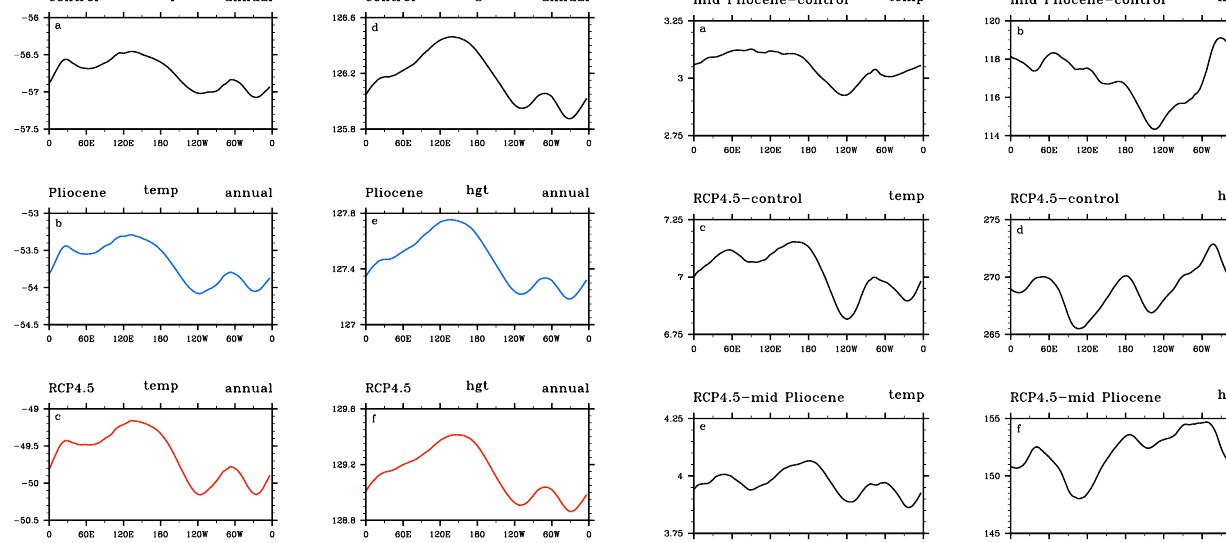
Fig. 8 (a) vertically averaged upper level (from 400hPa to 100hPa) temperature 2 Fig. 8. (a) Vertically averaged upper level (from 400hPa to 100hPa) anomaly (units: ºC) between mid-Pliocene and control run. (b) Potential height 3 temperature anomaly (units: ◦ C) between mid-Pliocene and the control run. (b) Potential height anomaly (units: m) between mid- anomaly (units: m) between mid-Pliocene and control run. (c) and (d) are same as (a) 4 Pliocene and control run. (c) and (d) are the same as (a) and (b) but and (b) but for differences between RCP4.5 and control run, respectively. (e) and (f) 5 for differences between RCP4.5 and the control run, respectively. are same as (a) and (b) but for differences between RCP4.5 and mid-Pliocene. 6 (e) and (f) are the same as (a) and (b) but for differences between RCP4.5 and